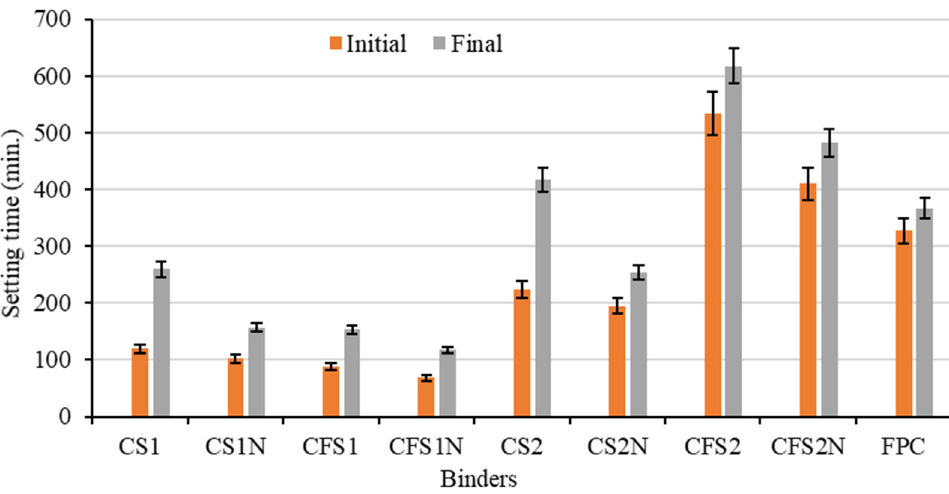
Figure 8. Initial and final setting times of